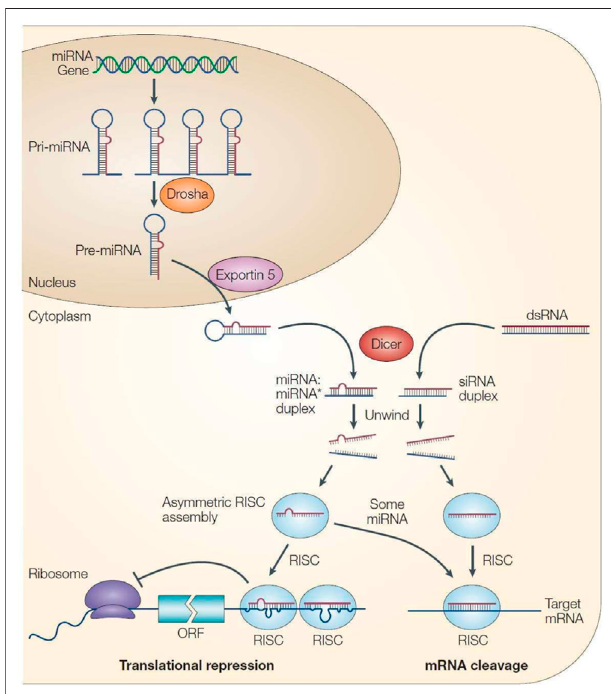
FIGURE2| Processing processand mechanismofactionofmiRNA (He and Hannon, 2004).